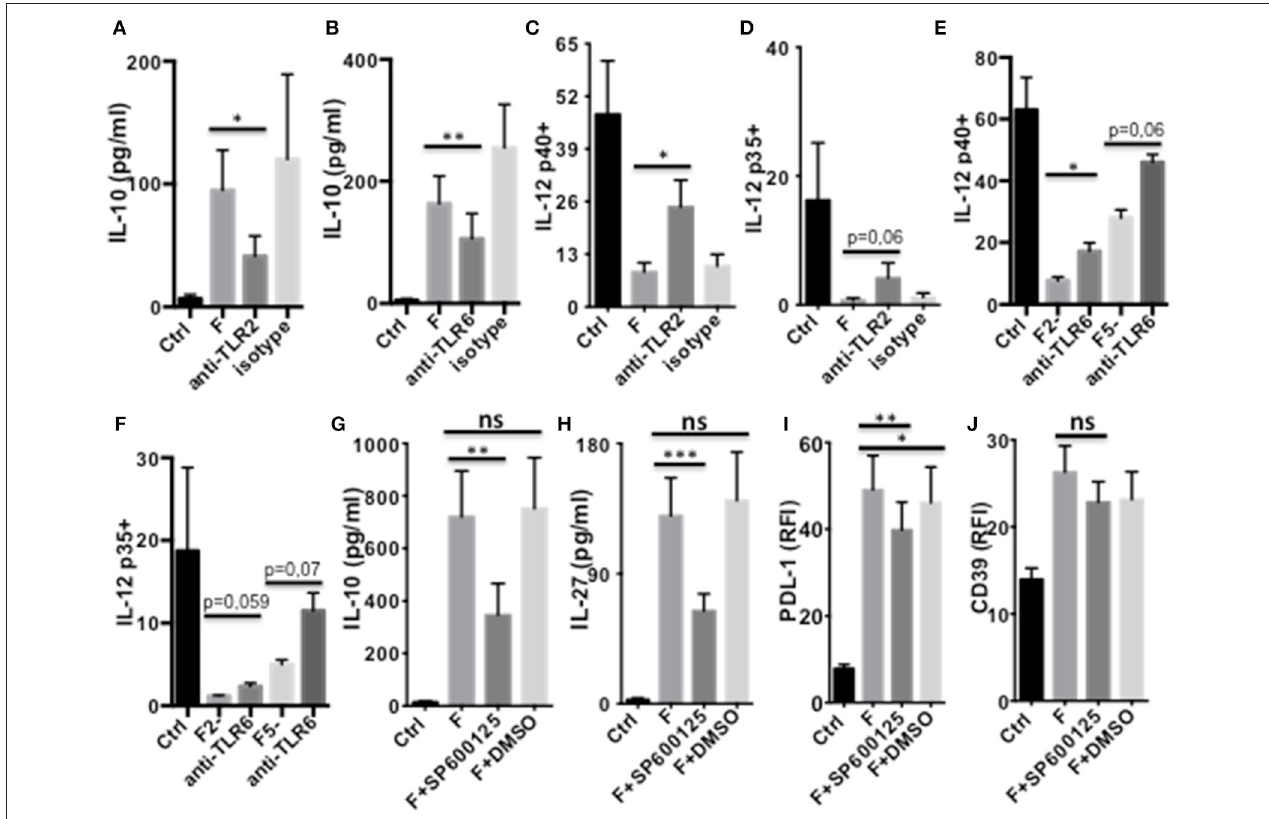
FIGURE 5 | TLR2/6- and JNK-dependent modulation of DC function by F. prausnitzii . (A,B) : IL-10-secretion by d5-DC exposed or not to F. prausnitzii for the last 24h, in the presence or not of neutralizing anti-TLR2 [ (A) n = 3] or anti-TLR6 Ab [ (B) n = 8]. (C–F) : LPS-induced IL-12p40 or p35 expression by DC exposed or not to F. prausnitzii at DC:bacterium ratios 1:1 (F or F1), 2:1 (F2-) or 5:1 (F5-), during the last 48h in the presence or not of neutralizing anti-TLR2 [ (C) n = 6, (D) n = 5] or -TLR6 Ab [ (E) n = 3, (F) n = 3]. Secretion of IL-10 [ (G) n = 9), IL-27 [ (H) n = 14] or expression of PDL-1 [ (I) n = 9] or CD39 [ (J) n = 12] by DC exposed or not (Ctrl) to F. prausnitzii for the last 24h, in the presence or not of the JNK inhibitor or its vehicle control DMSO. Paired t -test for n = 3, Wilcoxon test otherwise. * p < 0.05, ** p < 0.005, *** p < 0.0005.